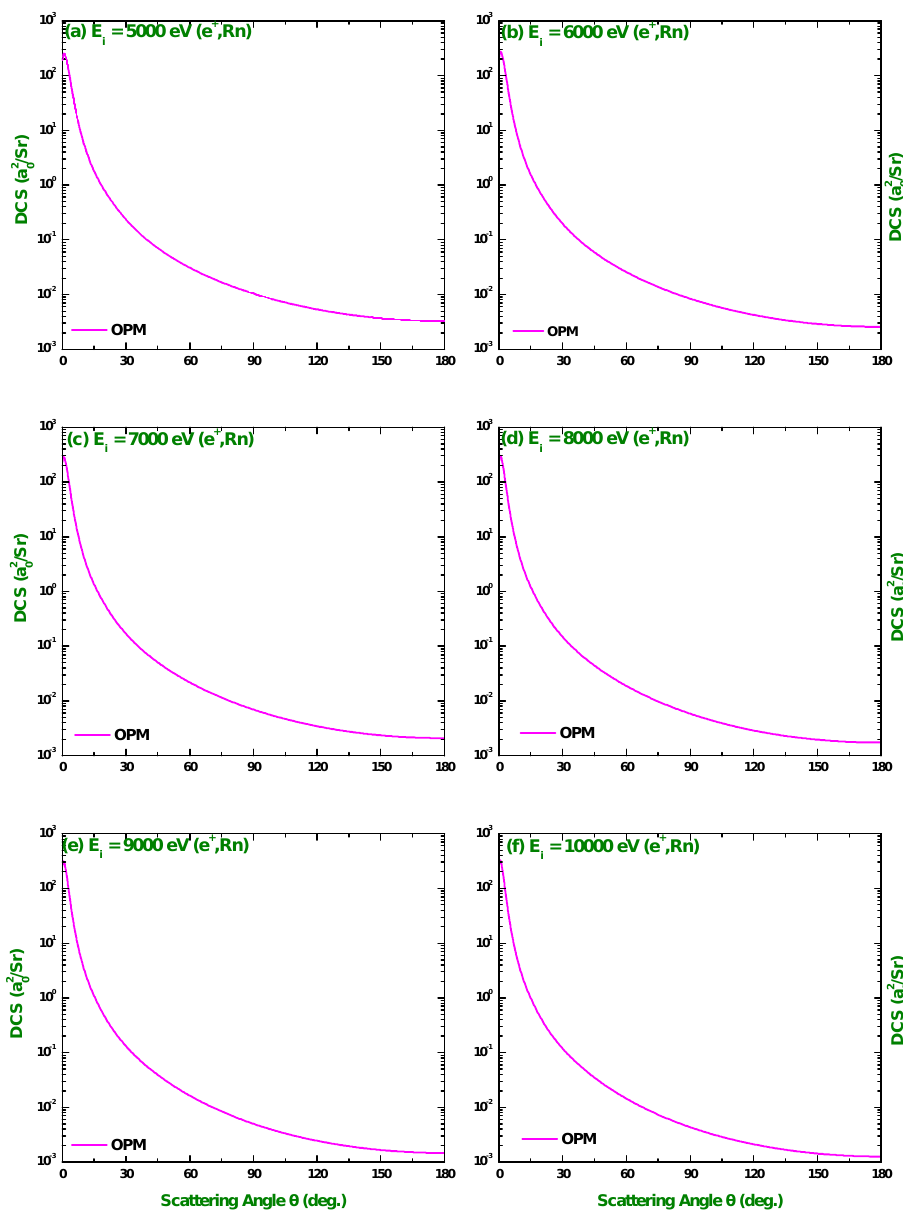
Figure 22. Same as Figure 19, but at impact energies of 5, 6, 7, 8, 9 and 10 keV. In Figure 23, we display energy dependence of the DCS and of the corresponding Sherman function for positron scattering from neutral radon atoms at three scattering angles 30 ◦ , 90 ◦ and 150 ◦ . As seen in this figure, minor structures appear in the DCS distributions at lower scattering angles, and they fade with the increase of energy. The present DCSs are again compared with those of Dapor and Miotello [21]. Similar to the case of electron scattering, the Sherman function increases with increasing scattering angles. However, the positron spin polarization is considerably smaller than that of its electron counterpart. This might be due to the Coulomb-dominated behavior of the positron potential